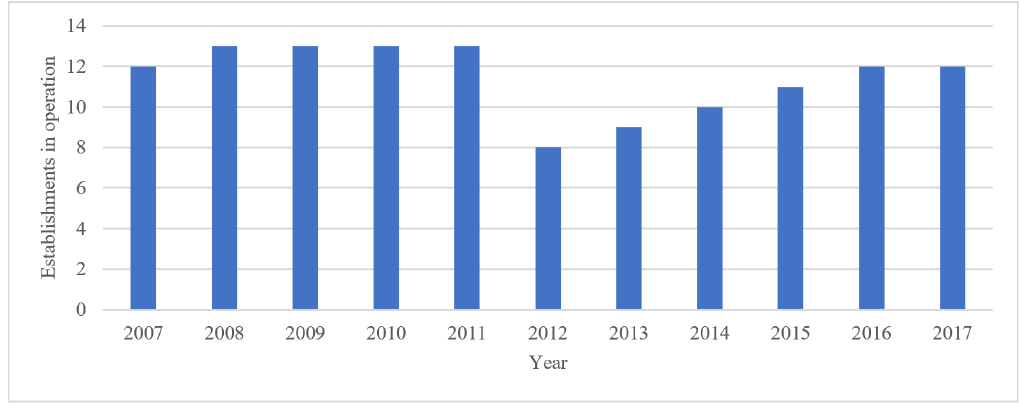
Figure 8. Number of hotel establishments in operation. (Source: Edited by Authors).